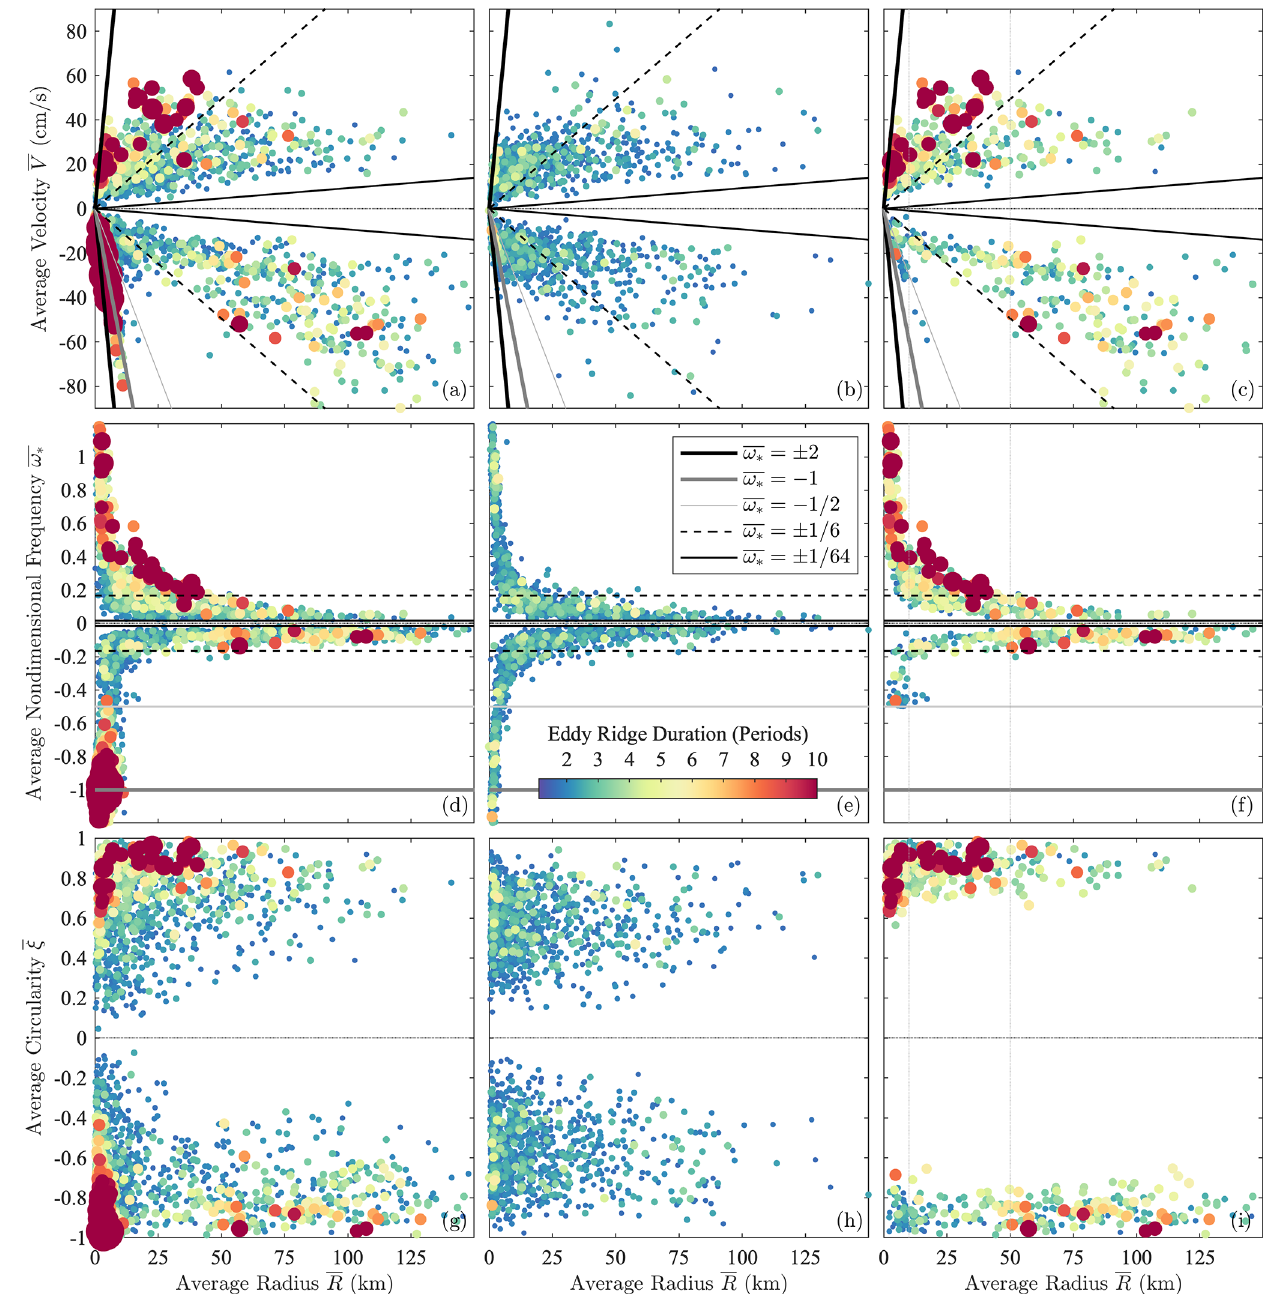
Figure 12. Scatterplots of ridge-averaged quantities for the drifter data (a, d, g) , for a noise dataset of the same size (b, e, h) , and for the drifter dataset after the application of the noninertial criterion ω ∗ > − 1 / 2 together with a significance criterion described later in the text (c, f, i) , specifically ρ X < 0 . 1 with X = Lξ 4 . In (a) – (c) , the location of each ridge in ridge-averaged radius R versus ridge-averaged velocity V is shown. The color and size both represent the ridge length L , defined to be the number of periods an oscillation executes along the ridge. In (d) – (f) , the y axis is now the ridge-averaged nondimensional frequency ω ∗ , while in (g) – (i) it is the ridge-averaged circularity ξ . Diagonal lines in the upper row, and horizontal lines in the central row, mark lines of constant ω ∗ as noted in the legend. As the ridges are found for 1 / 64 ≤ | ω ∗ (t) | ≤ 2, the magnitudes of ridge-averaged frequencies | ω ∗ | will generally be within that range. In the right-hand column, vertical lines at R = 10km and R = 50km denote apparent transitions between different